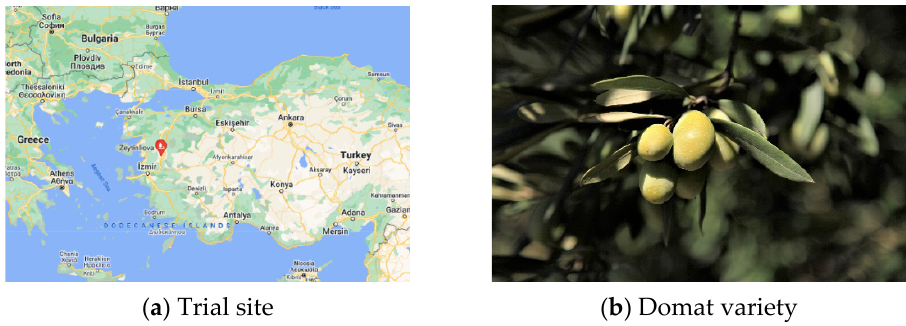
Figure 1. Geographic location of the experimental site ( a ) and fruits of “Domat” variety ( b ).